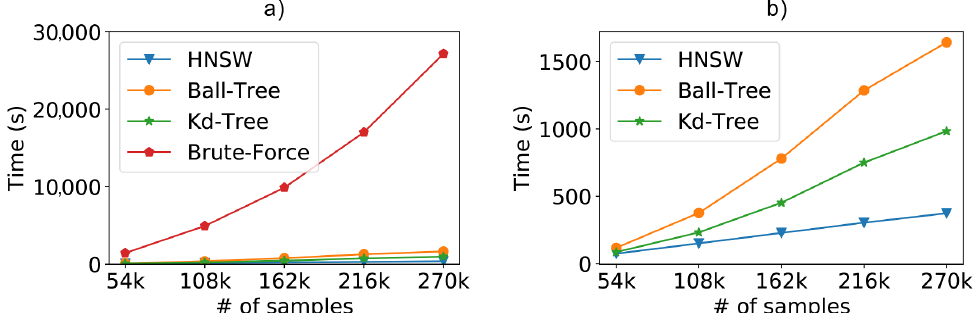
Figure 8. Scalability test results from a dataset containing 196 access points (attributes) and varying